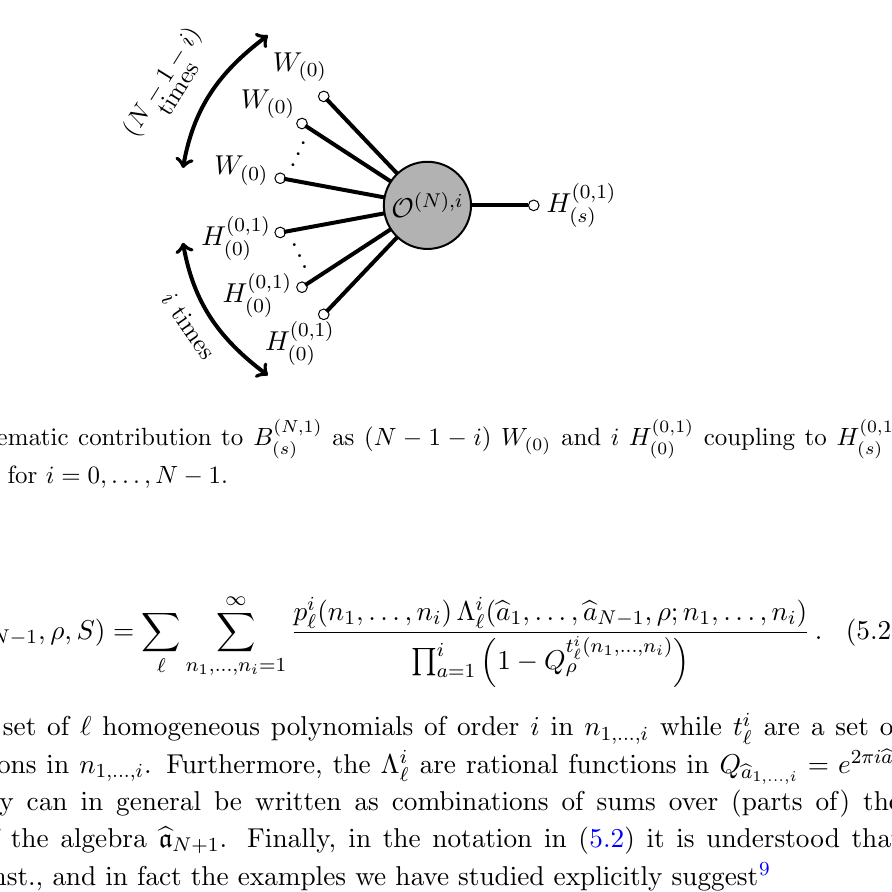
and i H (0 ; 1) coupling to H (0 ; 1) (0) (0)